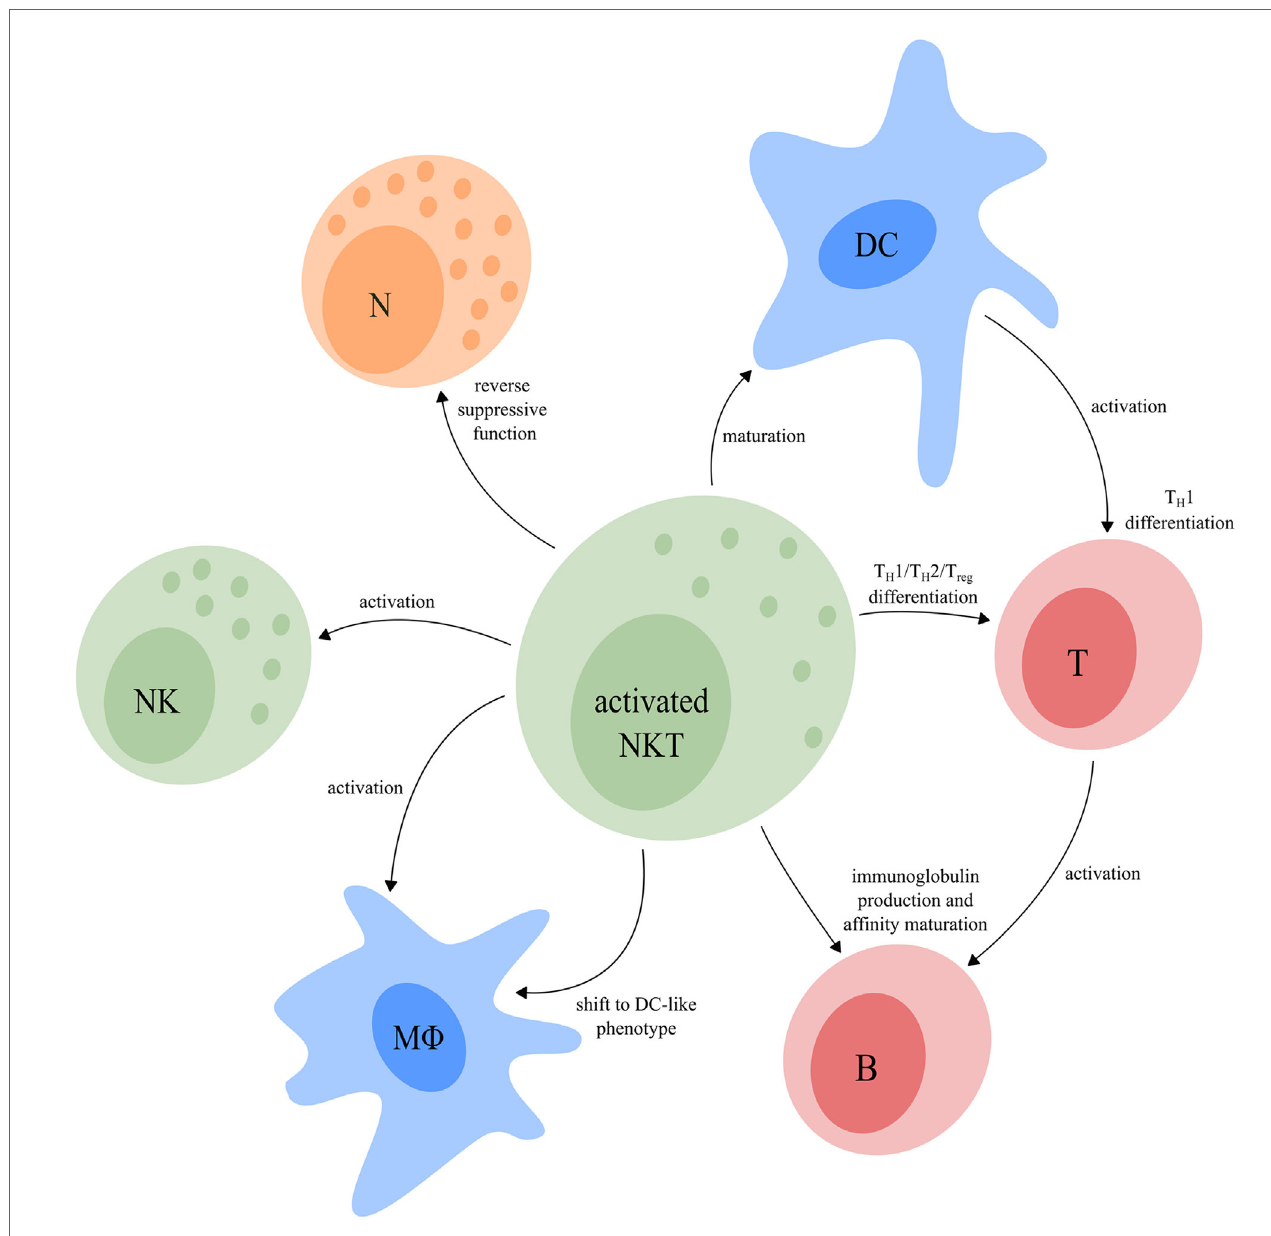
FigURe 4 | The regulatory function of activated NKT cells. Upon activation, NKT cells have a major influence on other immune cells. NKT cells can induce full maturation of DC upon which they activate T cells and induce T H 1 differentiation. Activated T cells interact with B cells resulting in their activation, as well as production of immunoglobulins and affinity maturation. The T FH type I NKT cell subset provides cognate help for B cells which promotes the production of immunoglobulins and affinity maturation. In addition, NKT cells can reverse the phenotype of immune suppressive neutrophils. Upon activation, NKT cells are also able to activate NK cells and macrophages and induce a functional shift of monocytes toward a DC-like phenotype. Finally, NKT cells can drive T cell differentiation to either a T H 1-, T H 2-, or T reg -profile, dependent on the NKT subsets involved. Abbreviations: NKT, natural killer T; DCs, dendritic cells; T H , helper T; T FH , follicular helper T; NK, natural killer; T reg , regulatory T; N, neutrophil; M Φ ,